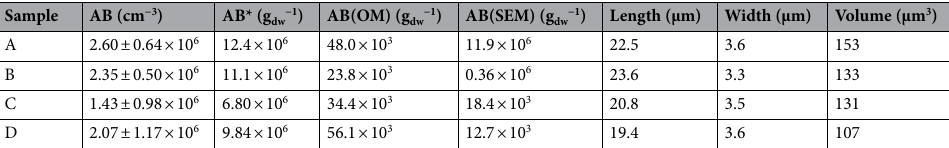
Table 2. Average number of AB and morphometry (length, width, and volume) for each sample. The number of AB derived from XPCµT measurements is reported per cubic centimeter (AB/cm 3 ) and converted per gram of dry weight of tissue (AB*/g dw ), using Eq. (1). The number of AB estimated by OM on digested tissues samples